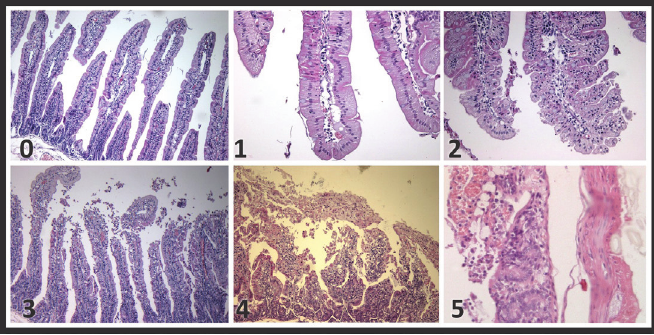
FIGURE 1 - Histopathology lesions intensity (Grade 0 to 5)